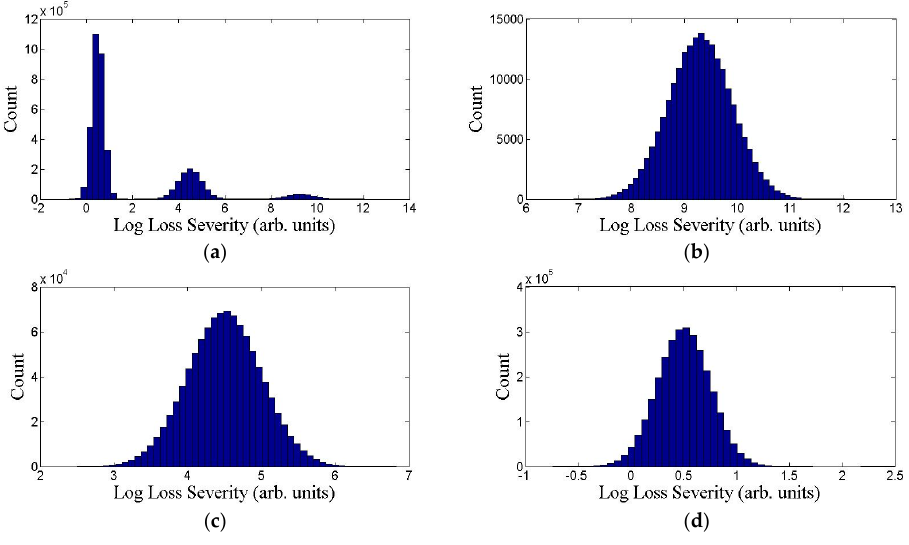
Figure 5. DPFS Method II applied to simulated Scenario II data. ( a ) Upper left panel is a histogram of the original loss data (log scale); the other three panels show the split into high ( b )/medium ( c )/low ( d ) severity regions. This method correctly identifies the three frequency/severity partitions in Scenario (II): (1) high severity/low frequency region ( b ); (2) medium severity/medium frequency region ( c ); (3) low severity/high frequency region ( d